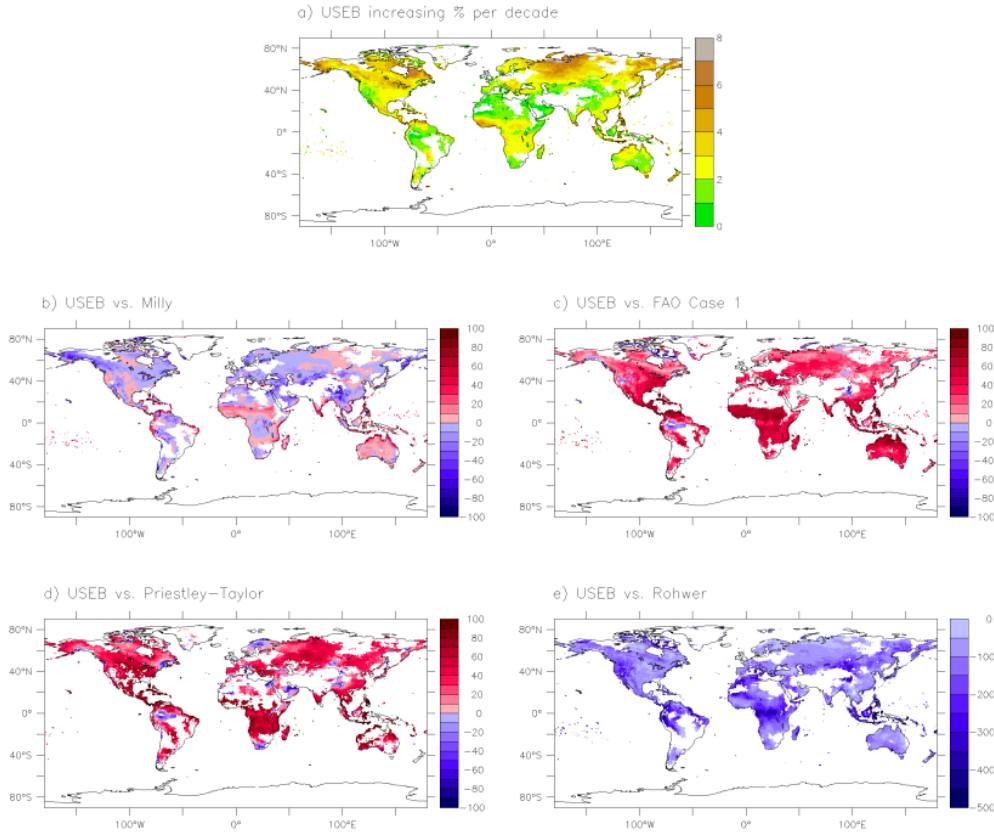
Fig. 3. The USEB method’s ET P significant trend showing the increasing % per decade (a) . Differences, given in % of percent change per decade, between the USEB and Milly methods (b) , between the USEB method and FAO’s case 1 (c) , and between the USEB method and the approximations of Priestley-Taylor and Rohwer ( d and e ). The blank areas correspond to regions where no significant trends have been